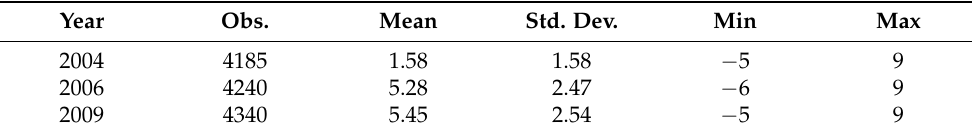
Table 2. Sample size used in this study.